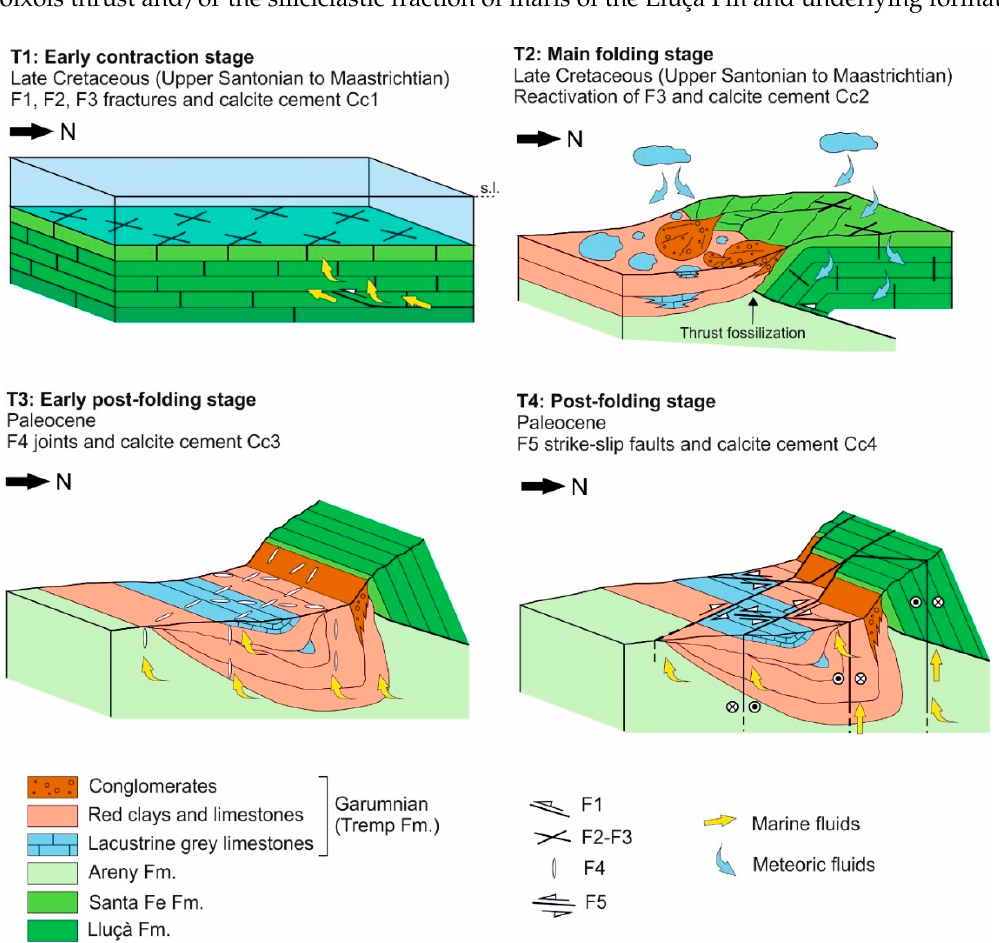
Figure 16. Fluid-flow model for the frontal part of the Bóixols thrust sheet showing the relationship between the structural evolution from early contraction to post-folding stage and the migration of fluids (not to scale).